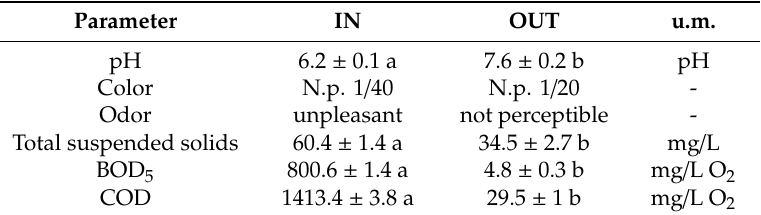
Table 1. Physical and chemical characteristics of PL in inflow and outflow. Di ff erent letters indicated that the di ff erences were significant ( p -value < 0.05).